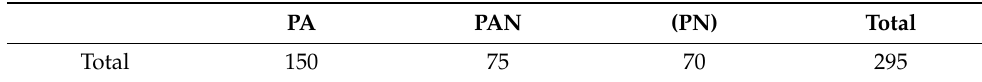
Table 1. Numbers of PA, PAN, and PN